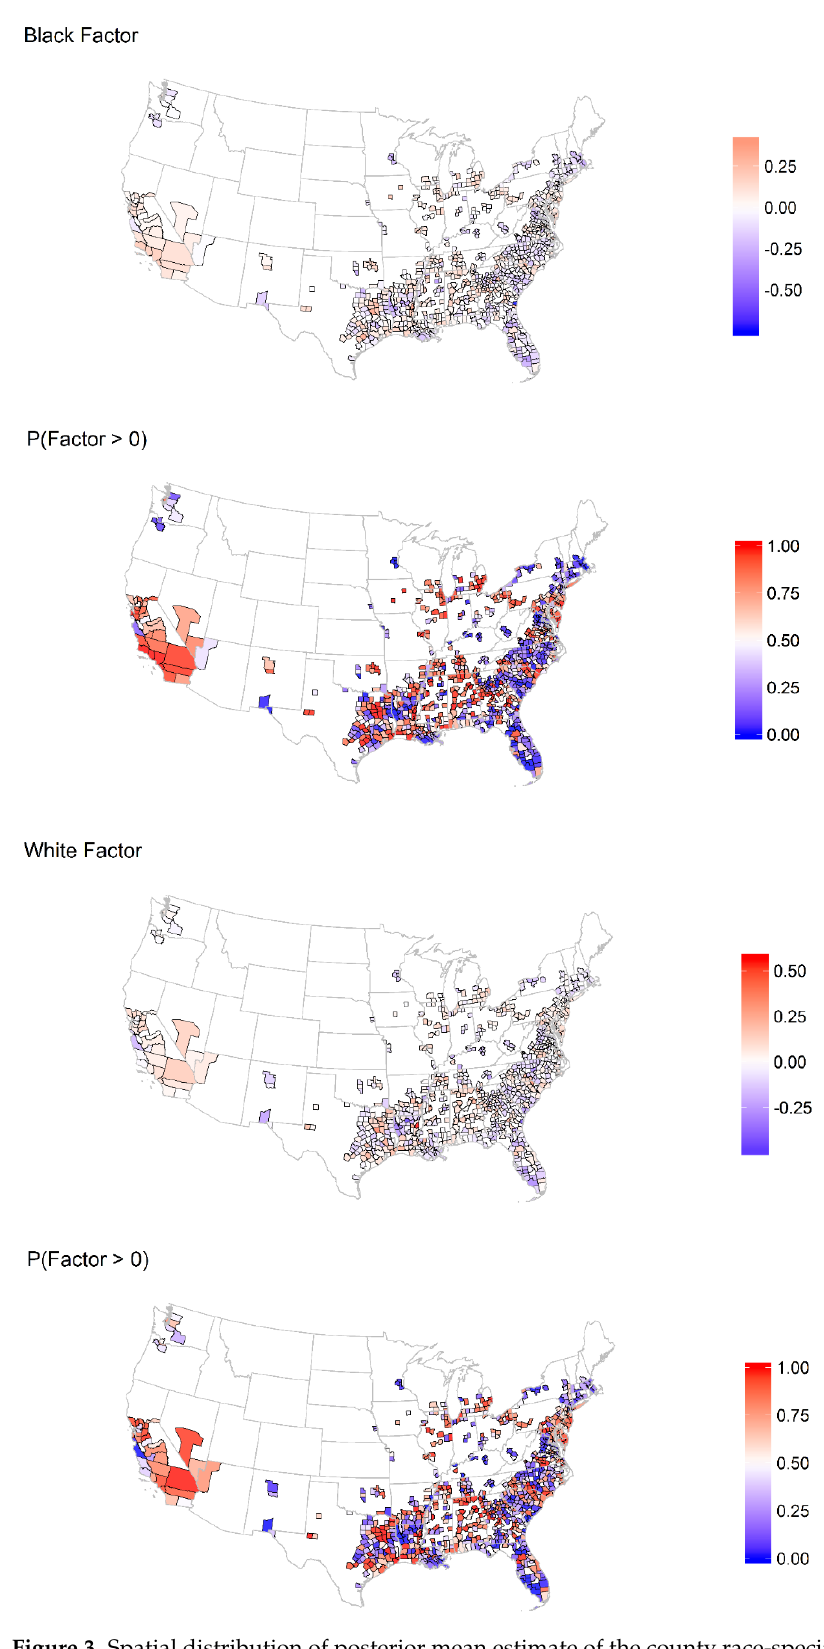
Figure 3. Spatial distribution of posterior mean estimate of the county race-specific factor and the posterior probability that it is above average.